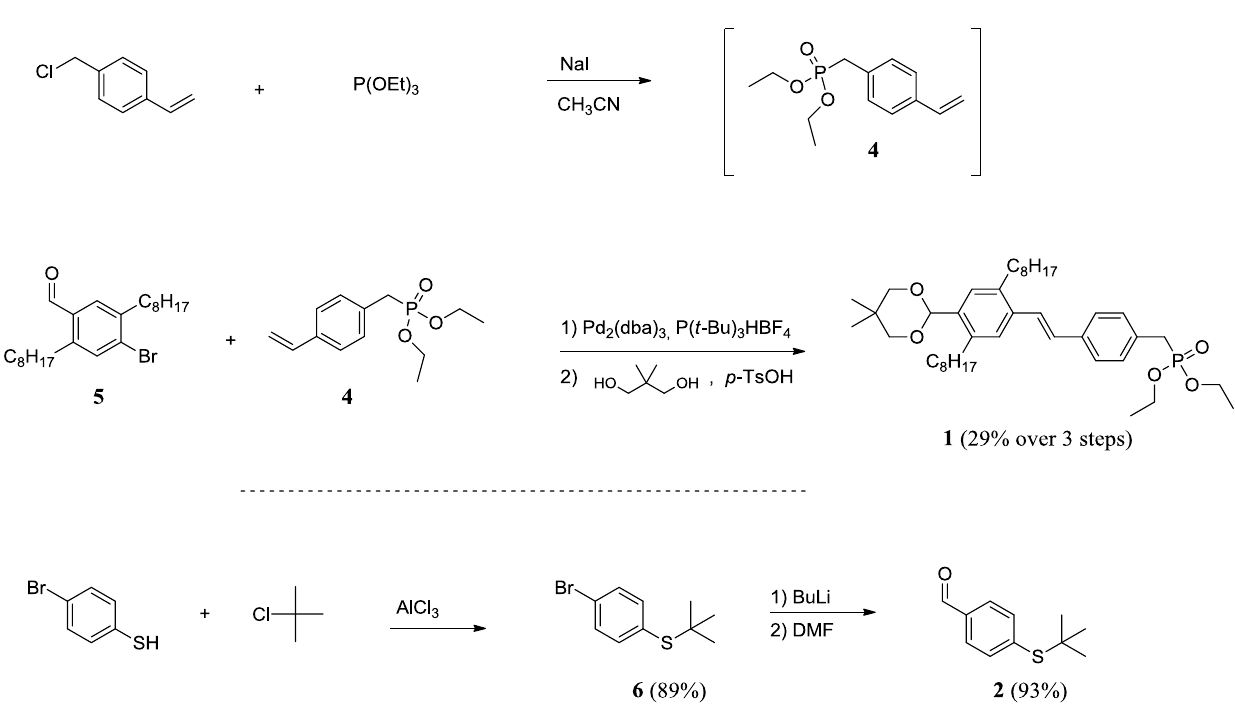
Scheme 1. Synthetic route to Compound 1 and 2